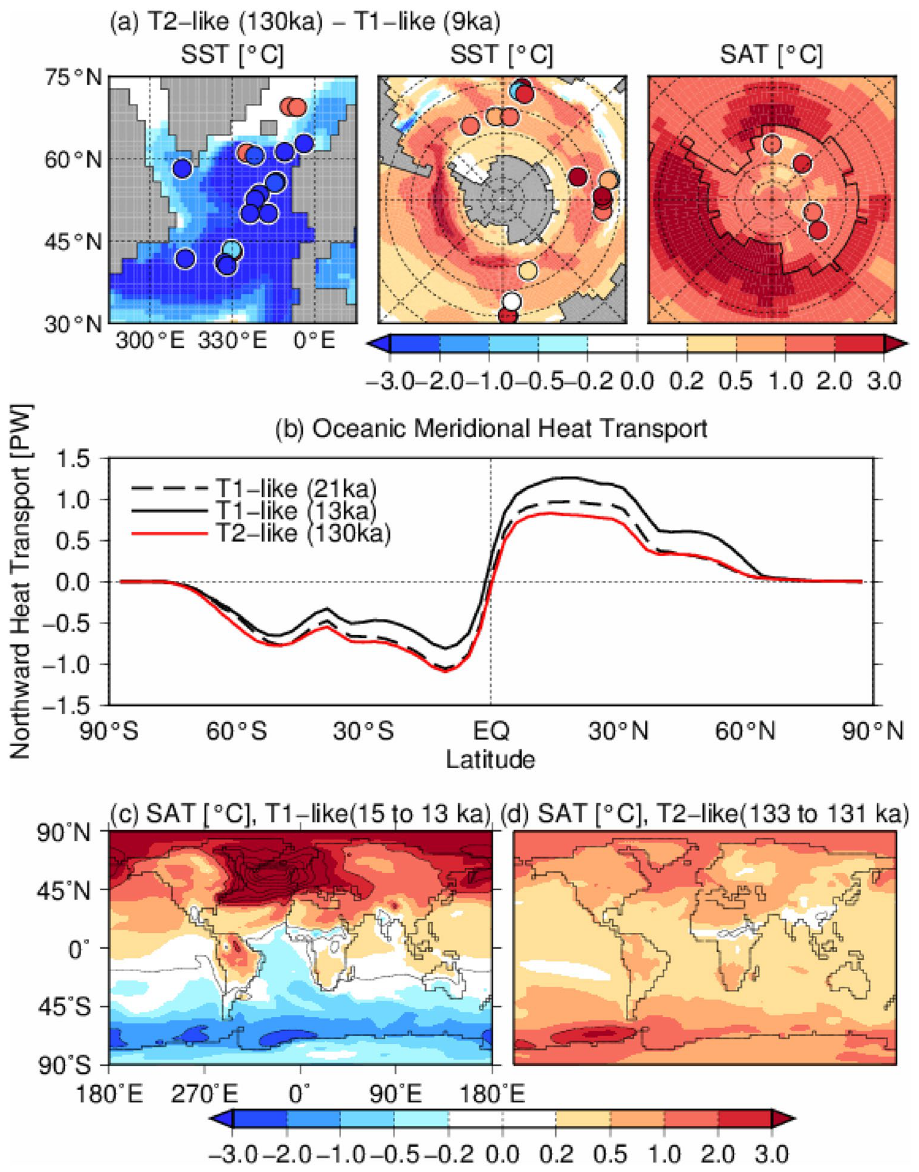
Figure 2. ( a ) SST and SAT difference between the T2-like experiment at 130 ka BP in relation to the T1-like experiment at 9 ka, corresponding to the Holocene level. The circles represent reconstructions (anomaly of 130 ka BP relative to the present 11 ). ( b ) Simulated oceanic meridional heat transport (positive indicates northward heat transport) at 21 ka and 13 ka in the T1-like experiment and at 130 ka in the T2-like experiment. ( c ) SAT change during in the T1-like (15–13 ka BP) and T2-like (133–131 ka BP) experiments, corresponding to the Antarctic Cold Reversal of T1. The maps were generated using GMT version 4.5.9 (URL: https:// www. soest. hawaii. edu/